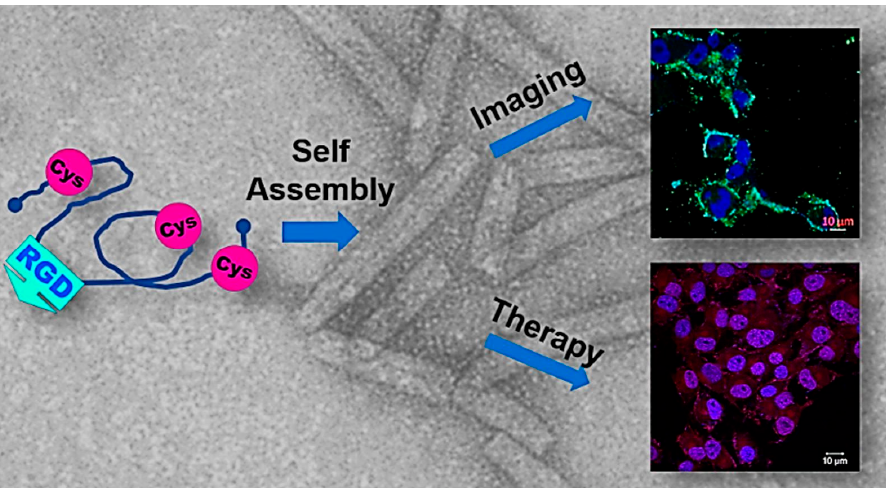
Figure 8. Multifunctional PNTs assembled from an engineered polypeptide from the human insulin-like growth factor binding protein-2 (hIGFBP-2). The polypeptide is generated from the C-terminal loop region (residues 249-289) of hIGFBP-2, with an additional cysteine added at position 281 (R281C) [127,128]. The presence of the three Cys residues (C249, C270, C281) results in the redox-controlled assembly/disassembly of PNTs. The recombinant hIGFBP-2 contains an RGD tripeptide enabling cellular targeting, and the PNTs can be labelled with FITC for imaging purposes or Doxirubicin for therapeutic action versus cancer cells. This multifunctional nature of the hIGFBP-2PNTs is an intriguing first step to adaptation of PNTs as multimodal targeting structures. (Figure adapted from Asampille et